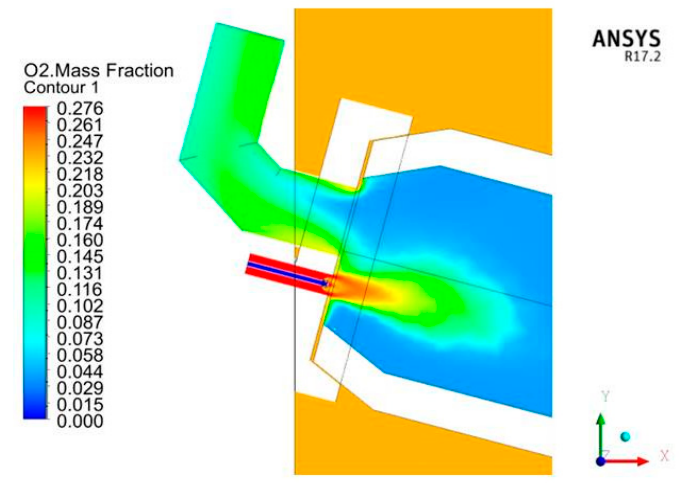
Figure 12. Model results: Distribution of oxygen mass fraction contours.